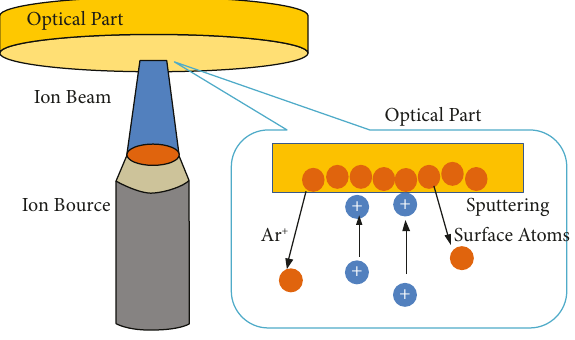
Figure 8: Ion beam polishing